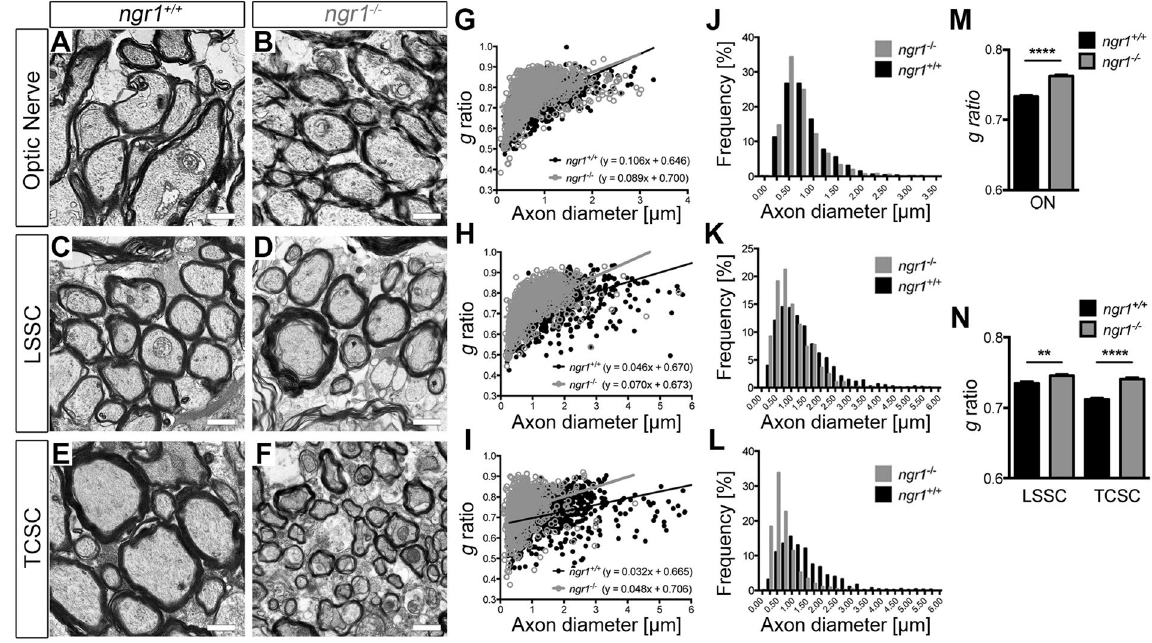
Figure 2. Thinner axon diameter and myelin thickness in ngr1 − / − mice. ( A – F ) EM images of ON ( A , B ), dorsolateral white matter of LSSC ( C , D ), and TCSC ( E , F ) cross sections of ngr1 + / + and ngr1 − / − mice (scale bar = 1 μ m). ( G – I ) Scatter plots display g ratios of individual myelinated axons as a function of the respective axon size and the linear regression of the g ratio measurements for each genotype is shown for the three CNS areas. ( J – L ) The percentage of myelinated axons with respect to axon diameter at 0.25 μ m intervals for the three CNS areas. ( M , N ) The mean g ratios of ngr1 + / + and ngr1 − / − mice ( ** P < 0.01, **** P < 0.0001, n = 8 for both